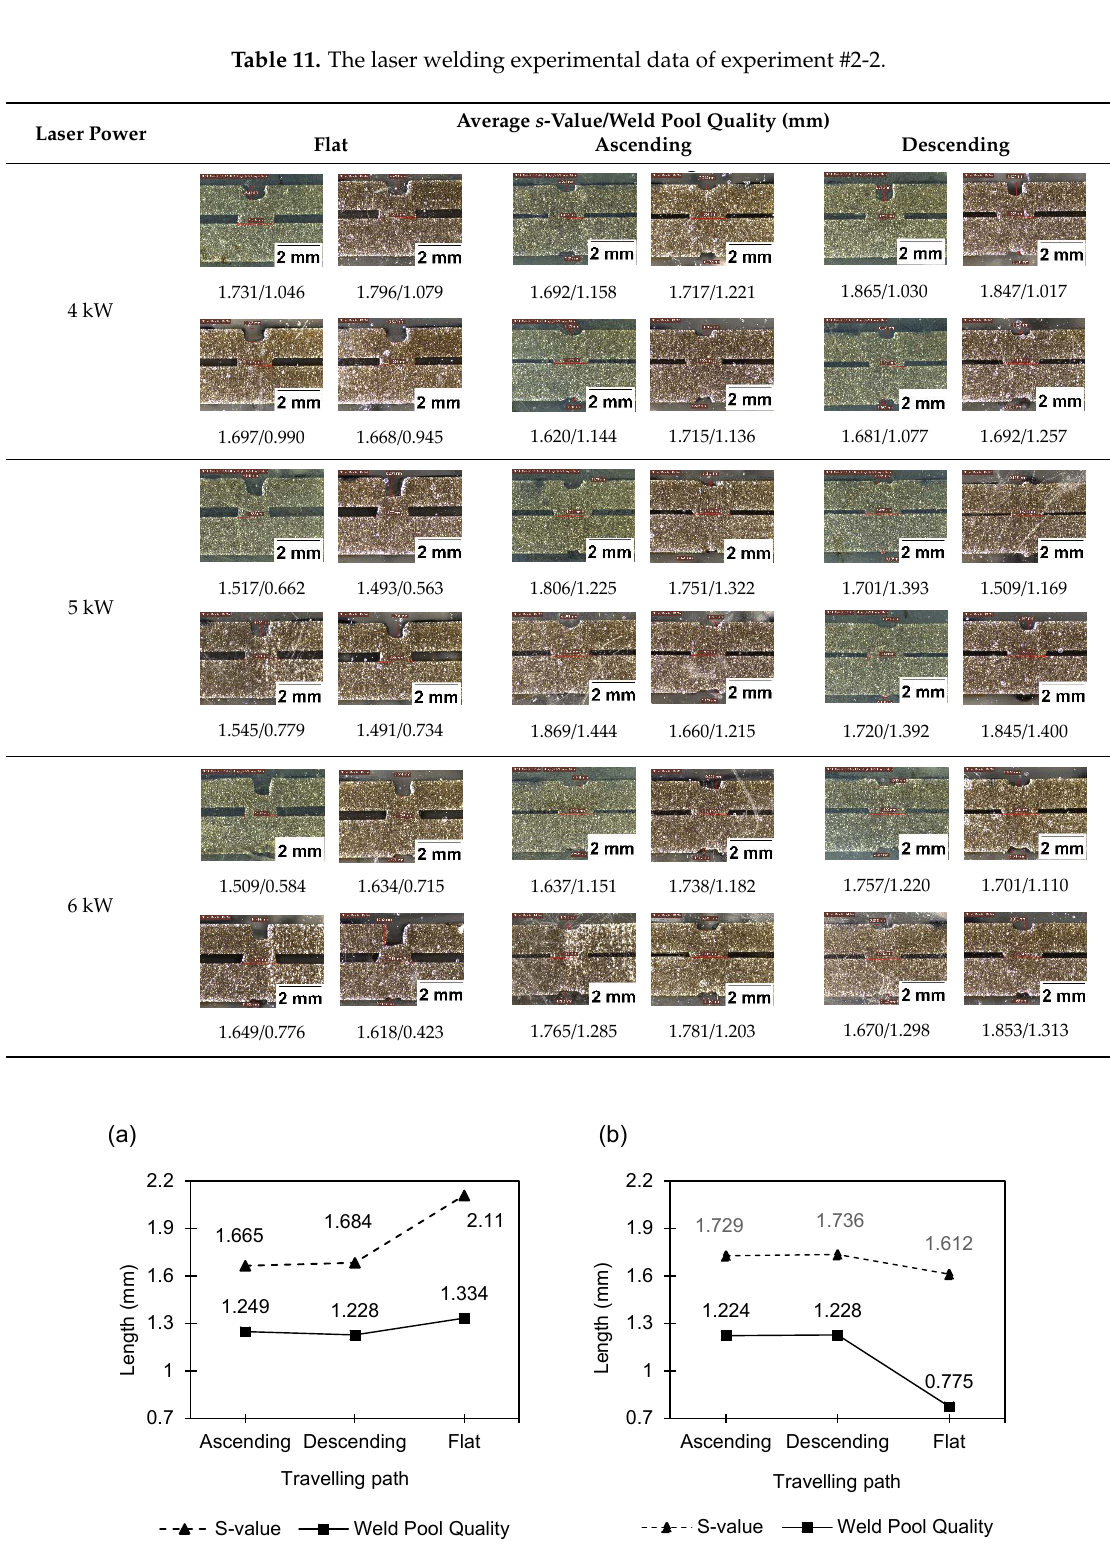
Table 11. The laser welding experimental data of experiment #2-2.